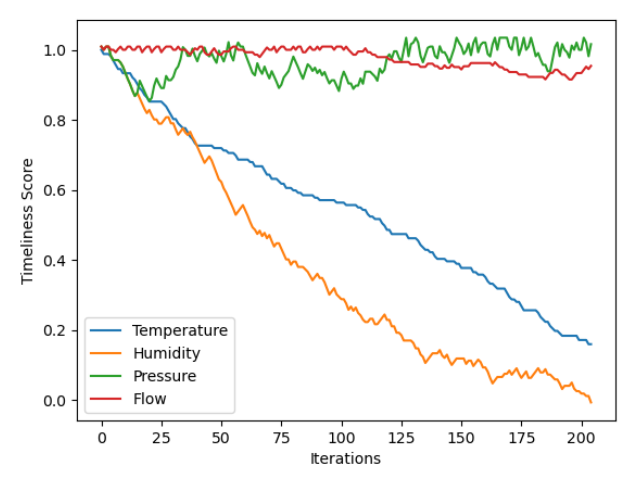
Figure 8. The convergence trend of the model considering multiple attributes.